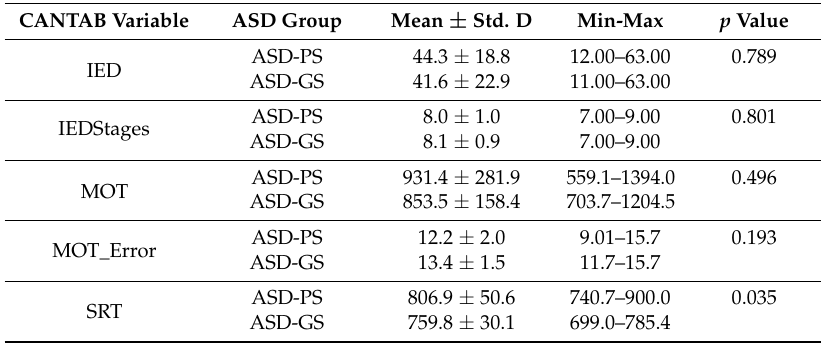
Table 2. Comparison of Cambridge Neuropsychological Test Automated Battery (CANTAB) tasks including, intradimensional/extradimensional shift (IED) motor planning task (MOT), simple reaction time task (SRT), among ASD Poor Sleepers (ASD-PS), ASD Good Sleepers